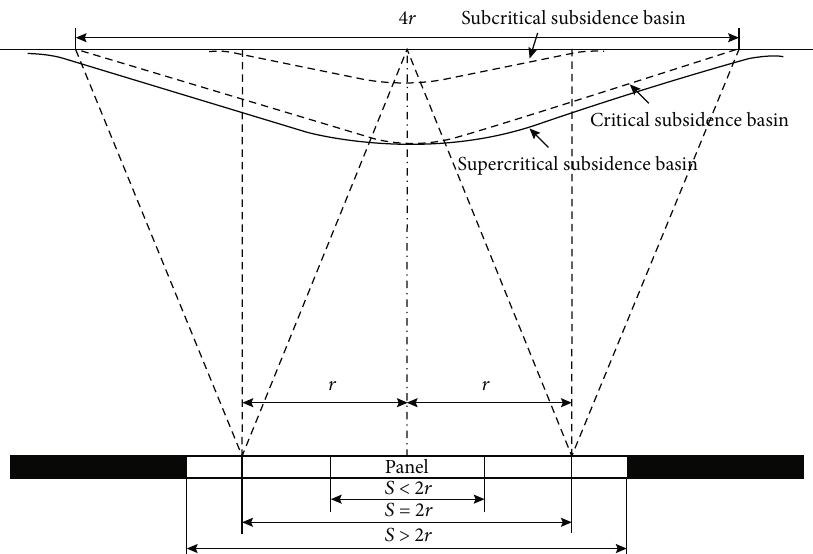
Figure 1: Surface subsidence basin types due to major cross-section excavation